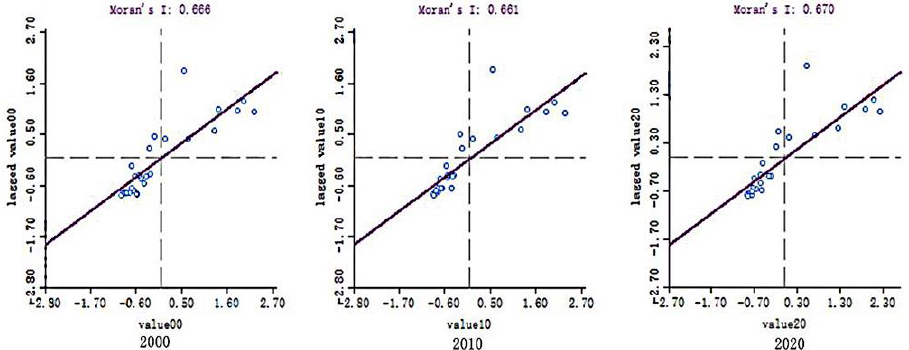
Figure 6. Scatter plot of Moran’s I index of the ESV per unit area in each district and county in the Loess Plateau of Northern Shaanxi.